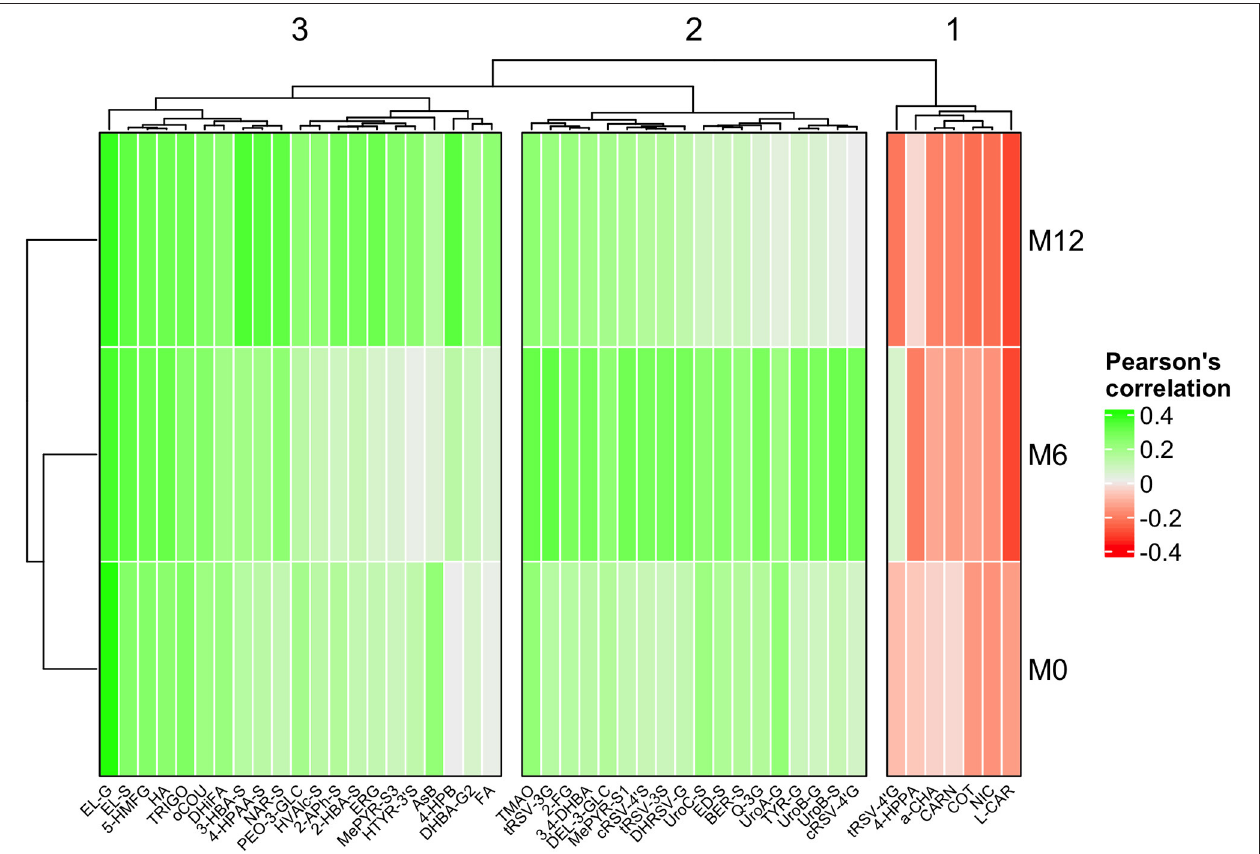
FIGURE 1 | Clustered heatmap showing Pearson’s correlation across the three study points between the AHEI-2010 and those metabolites selected by LASSO or limma approaches, respectively. Cluster 1 shows those metabolites that tend to be negatively associated with AHEI-2010 at the three study time points. Clusters 2 and 3 show those metabolites positively associated with AHEI-2010 at each of the three study time points, making a slight distinction between those most strongly associated at time M6 (Cluster 2), and times M0 and M12 (Cluster 3).